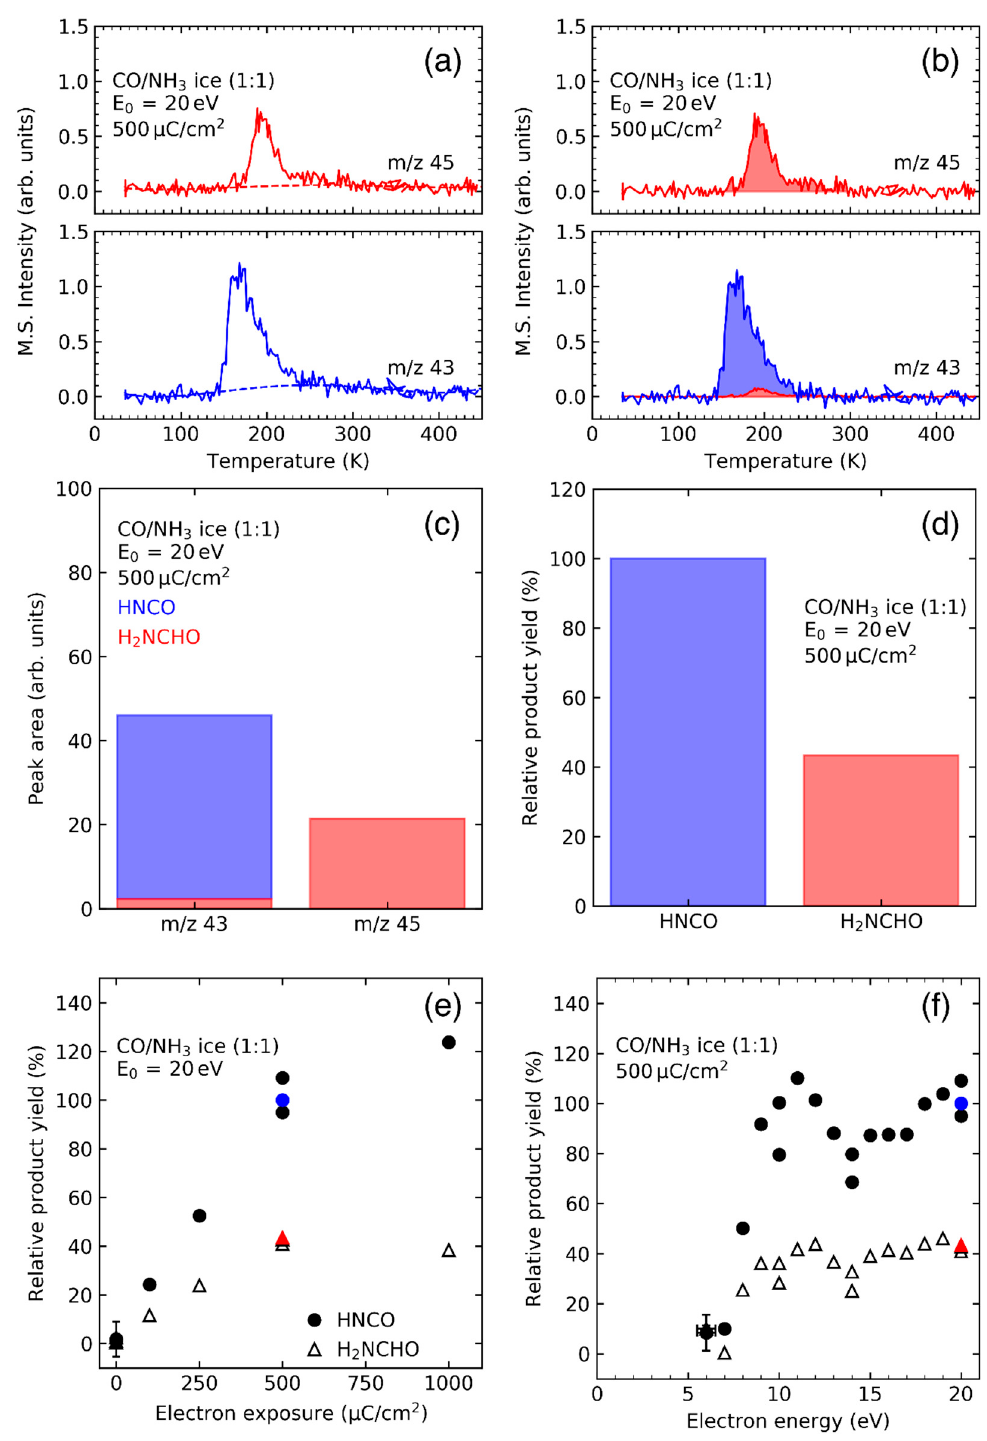
Figure 1. Procedure to derive product yields as function of electron energy from TDS